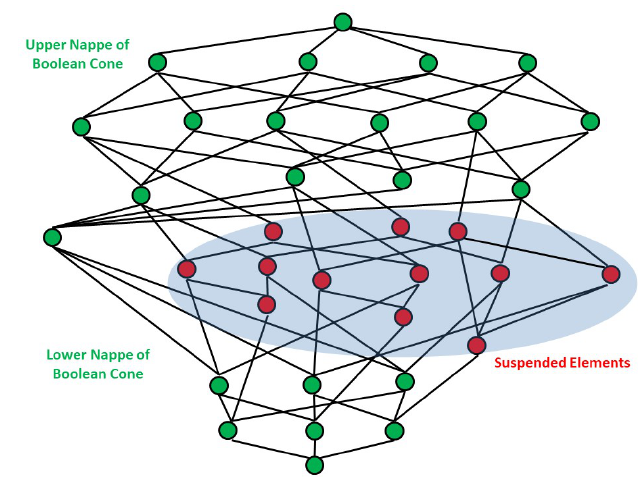
Figure 9 Anatomy of a Graph